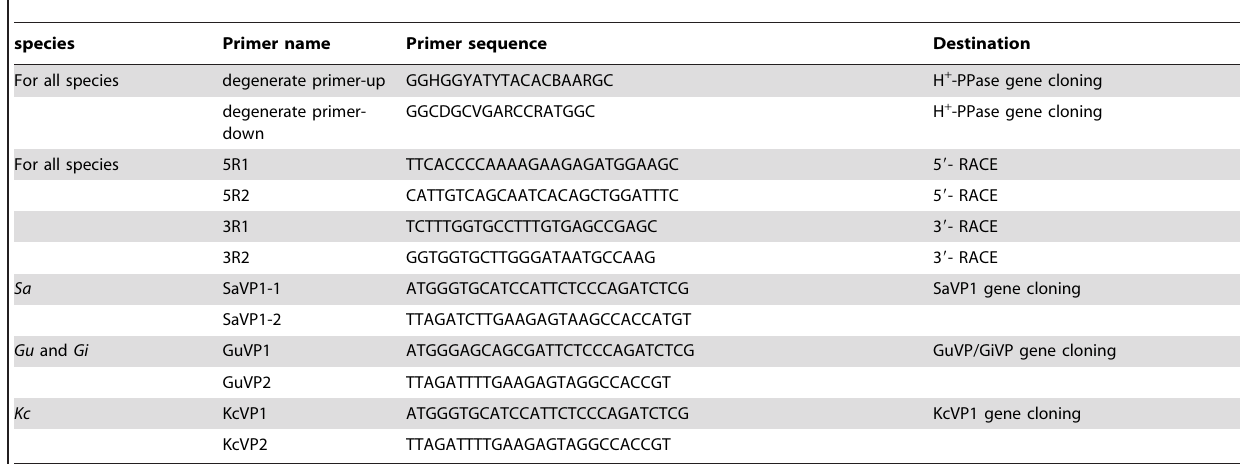
Table 1. Primers for RACE and ORF of the H + -PPases from the 7 eremophytes.